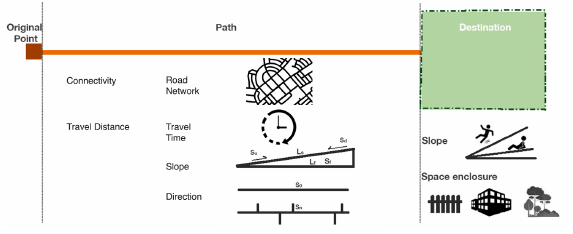
Figure 1. Schematic diagram of walking space structure and impact spatial